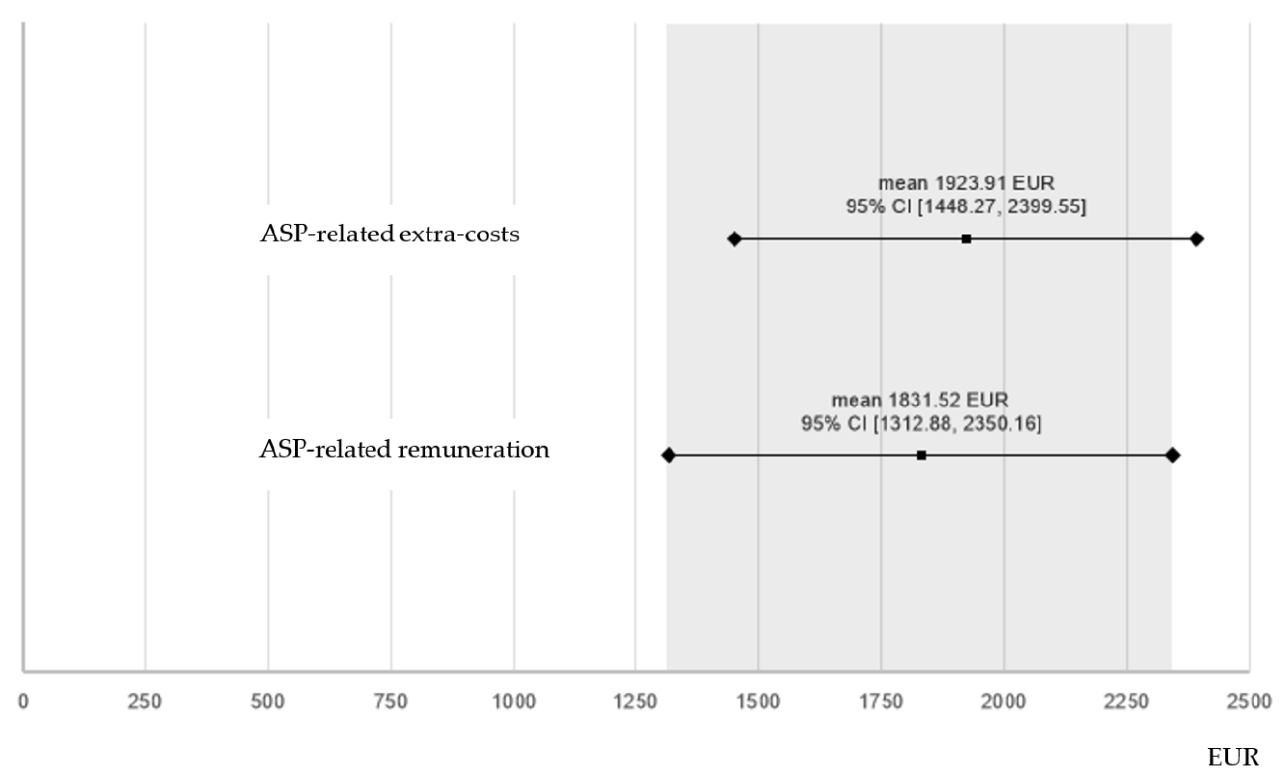
Figure 4. Average remuneration for ASP (EUR 1831.52 [difference between average reimbursements for NSF + ASP and NSF]) is slightly below mean sacroplasty-related extra-costs for implants/devices and extended surgical time (EUR 1923.91). The 95% CI of expenditure for ASP overlaps the upper margin of the 95% CI of sacroplasty-related remuneration (grey field), indicating almost cost-coverage, but non-profitability of ASP. NSF indicates navigation-assisted screw fixation; ASP, additional sacroplasty; 95% CI, 95% confidence interval.